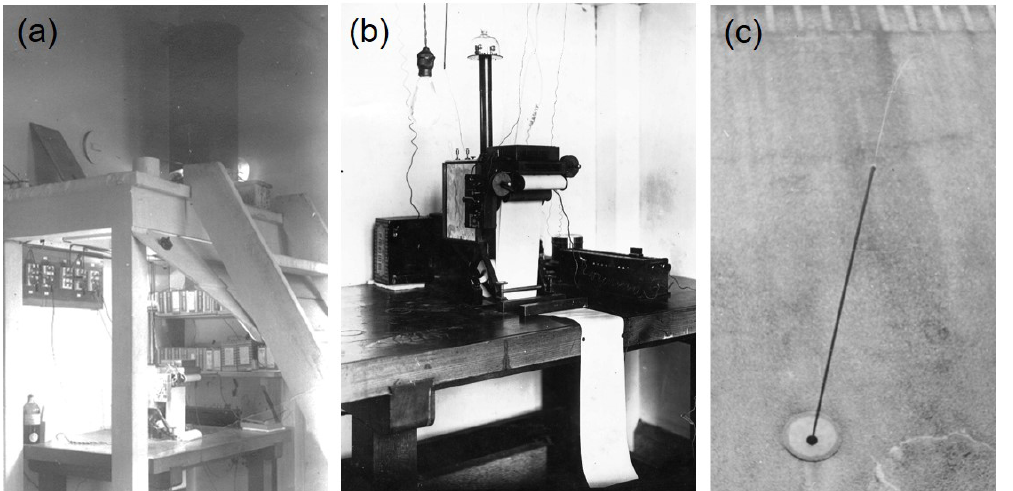
Figure 12. (a) The observation system of atmospheric electric field observation in 1937. The Bendorf electrometer (b) is on a desk on a lower floor, and a black water tank of the Kelvin water dropper is next to the wall on an upper floor. A water nozzle (c) extends from the tank through a hole of the wall to the outside (photo supplied by Kakioka Magnetic Observatory).